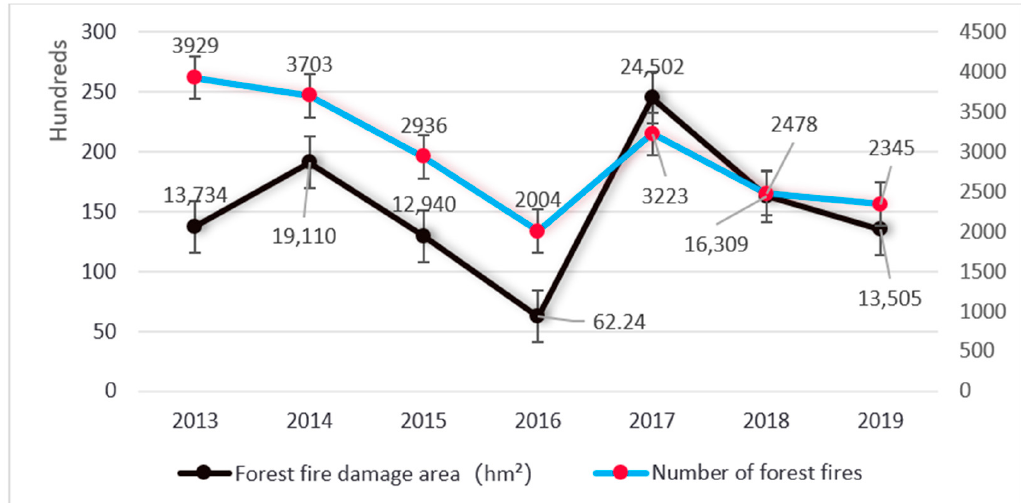
Figure 2. Yearly changes in the area and number of forest fires in China (2013–2019).